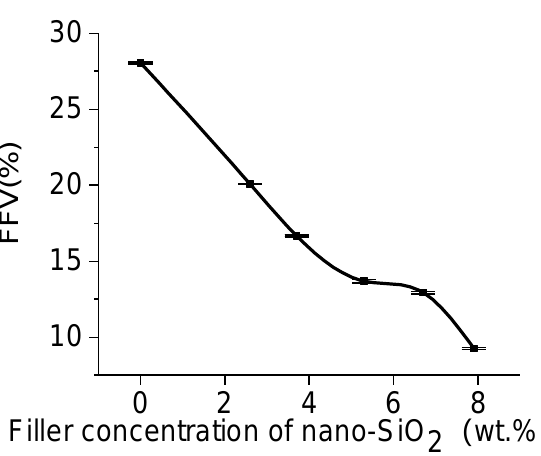
Figure 8. Fractional free volume (FFV) of PUF-SiO 2 models. Table 2. Fractional free volume of PUF- SiO 2 models (mean ± standard error).